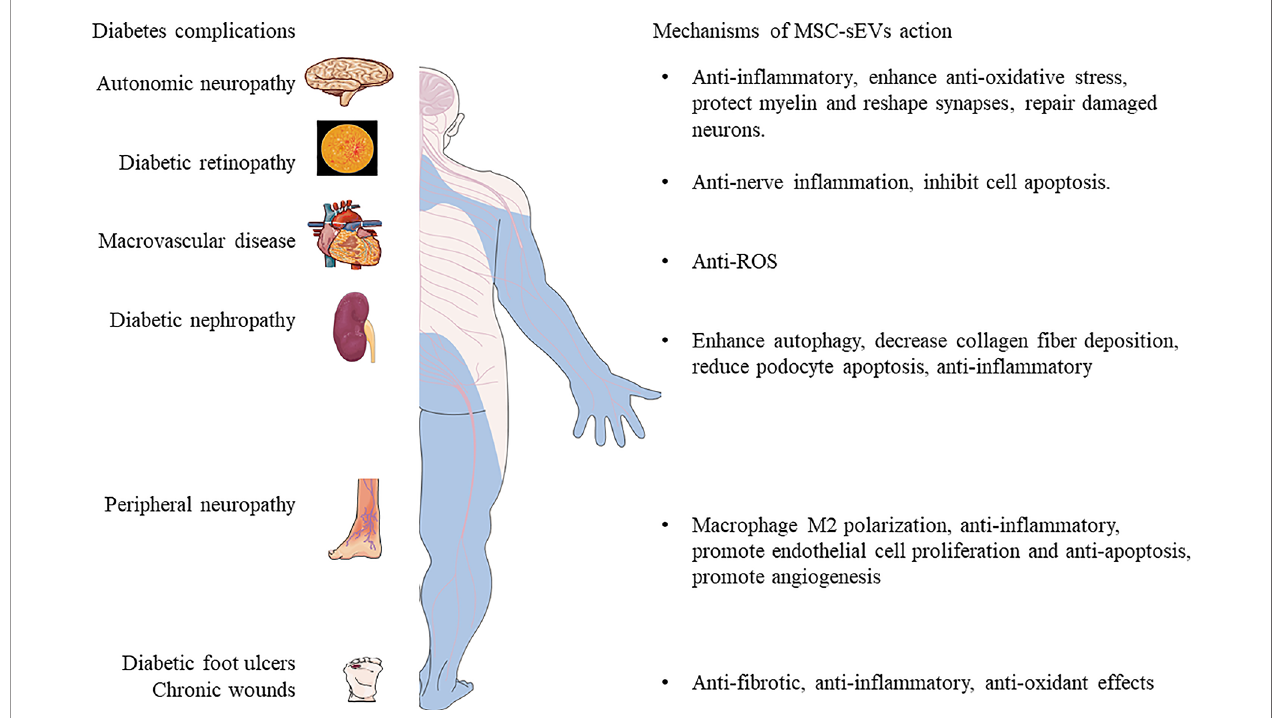
FIGURE 3 | The mechanisms of MSC-sEVs in the treatment of complex diabetic